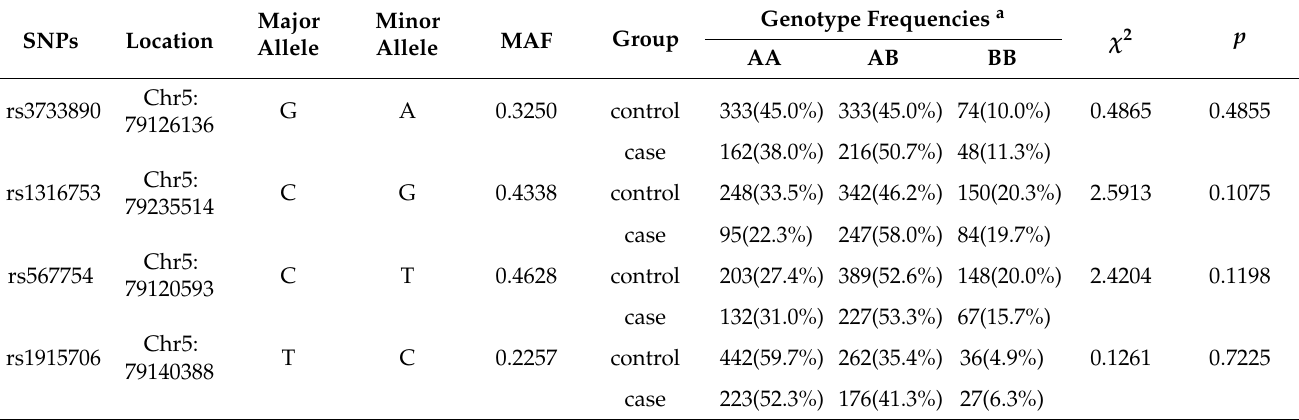
Table 3. Genotypic frequencies of maternal BHMT polymorphisms and P values of HWE test.